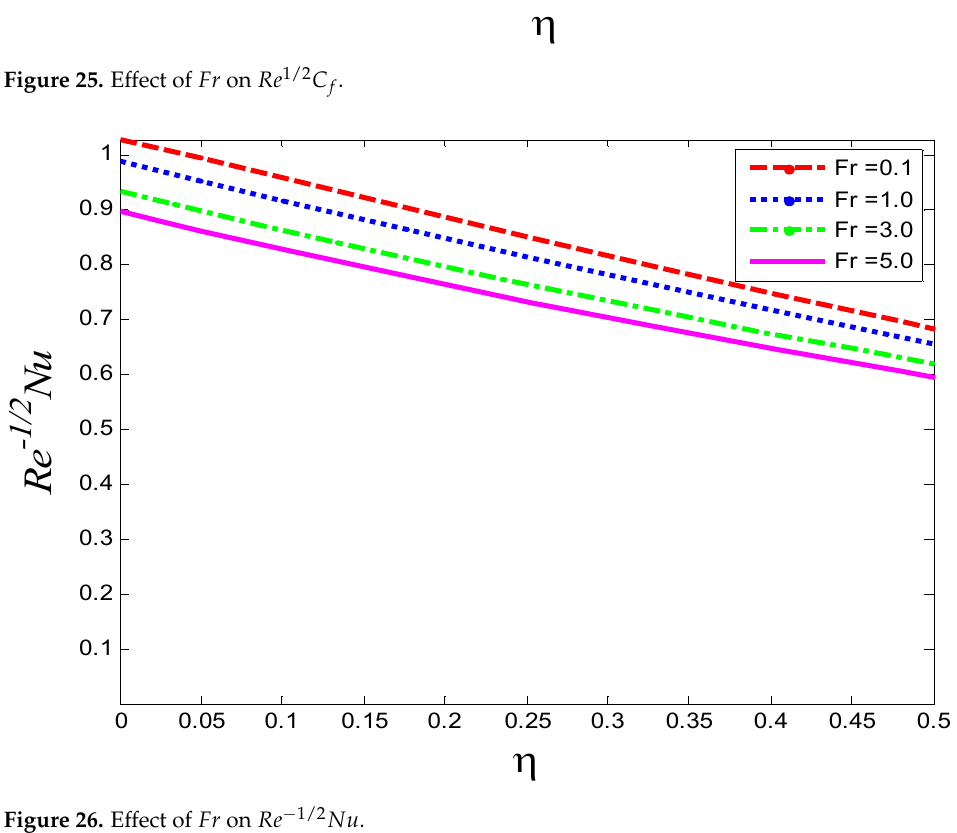
Figure 26. Effect of Fr on Re − 1/2 Nu